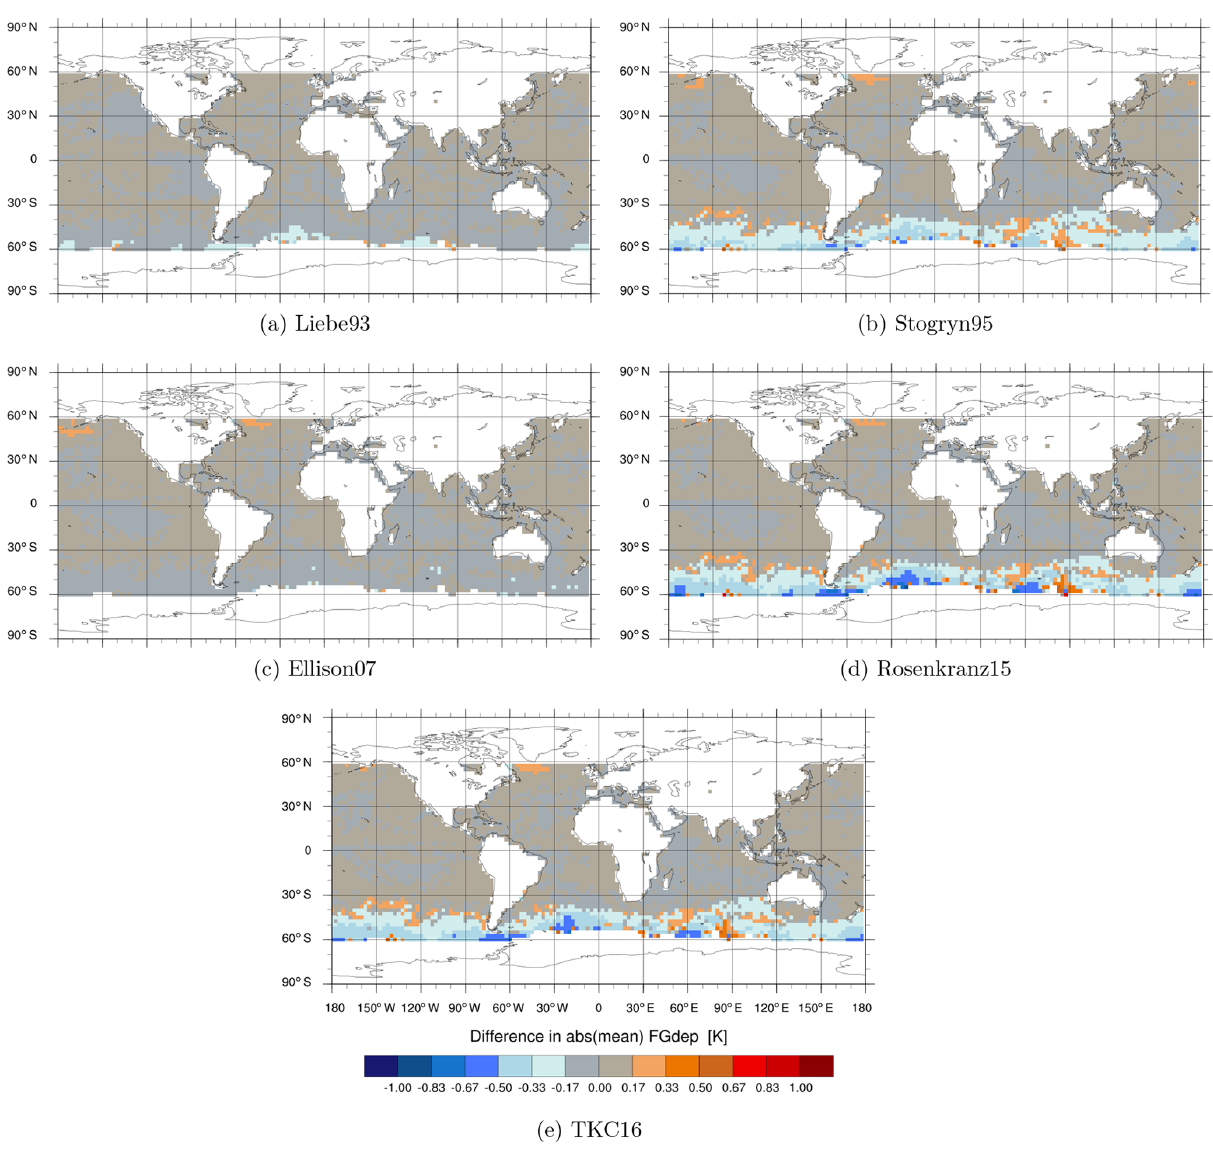
Figure A1. Maps of differences in absolute values of observed minus simulated brightness temperatures [K] between the newer liquid water permittivity models and the current Liebe89 for 37v brightness temperatures co-located to corresponding SSMIS-F17 observations. Means are computed in each 2.5 ◦ lat × 2.5 ◦ long bin and over the time period 1 to 31 August 2016. White areas correspond to areas in which data are not assimilated, as mentioned in Sect.